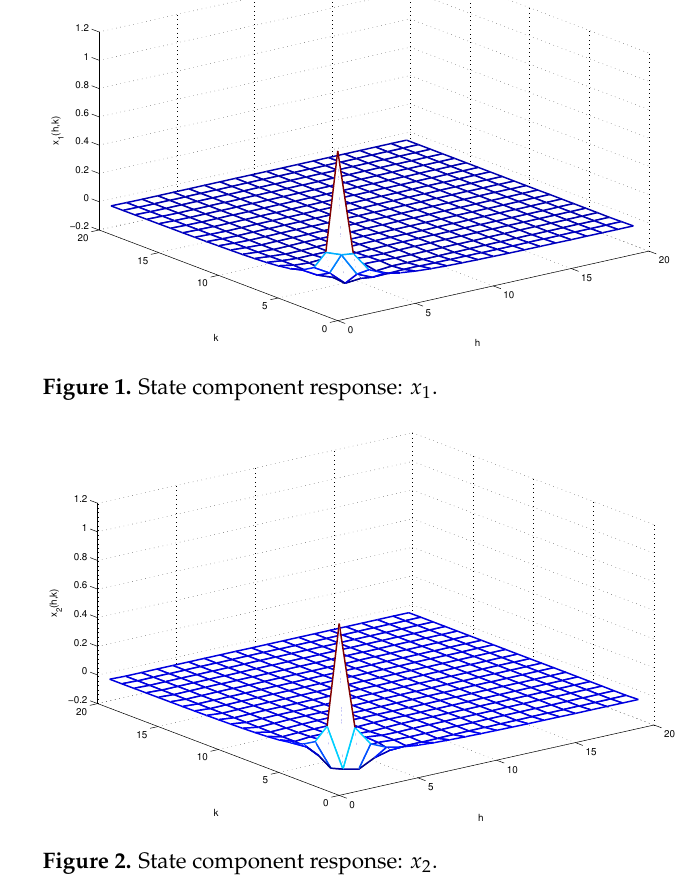
Figure 2. State component response: x 2